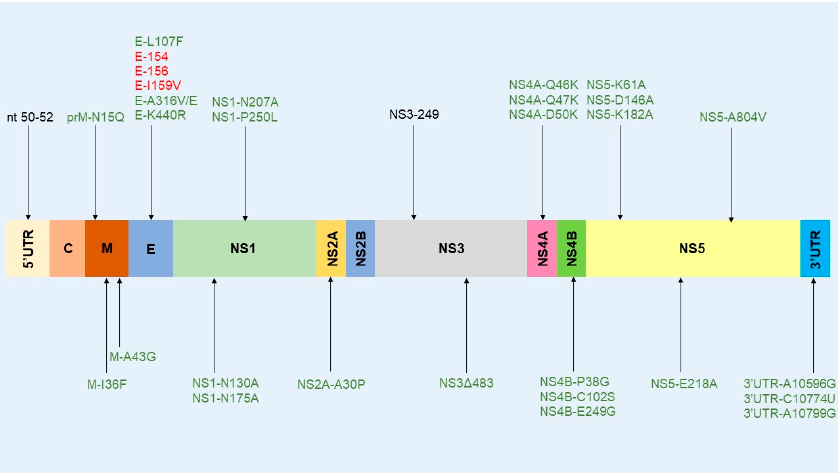
Figure 6. Virulence determinants in the WNV genome found in mammalian hosts. Molecular virulence determinants found in vitro or in vivo in mammalian cells (Vero, A549) and mouse models are represented throughout the entire WNV genome. Green: mutations involved in the attenuated viral phenotype. Red: mutations involved in the more virulent viral phenotype (adapted from [88]).